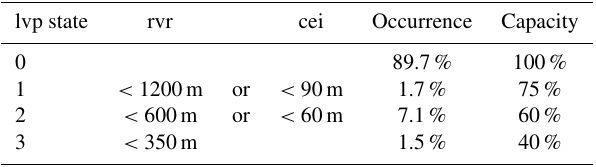
Table 1. Definition of the lvp states with their thresholds in runway visual range (rvr) and ceiling (cei), their climatological occurrence probability, and their maximum operational capacity utilization for Vienna International Airport. The climatological occurrence prob- ability is computed during the cold seasons (October–March) from November 2011 to November 2017 at 06:00UTC. lvp state rvr cei Occurrence Capacity 89.7%